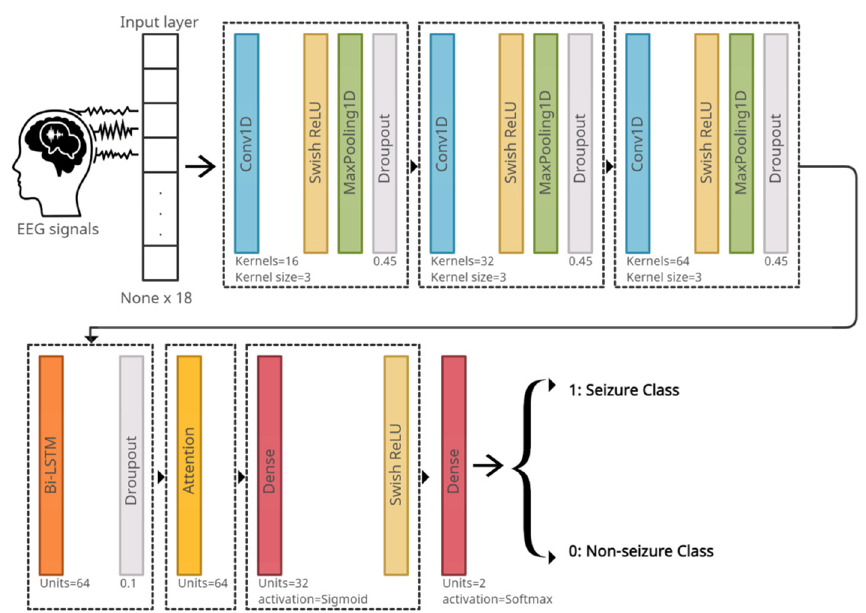
Figure 5. The deep-learning model